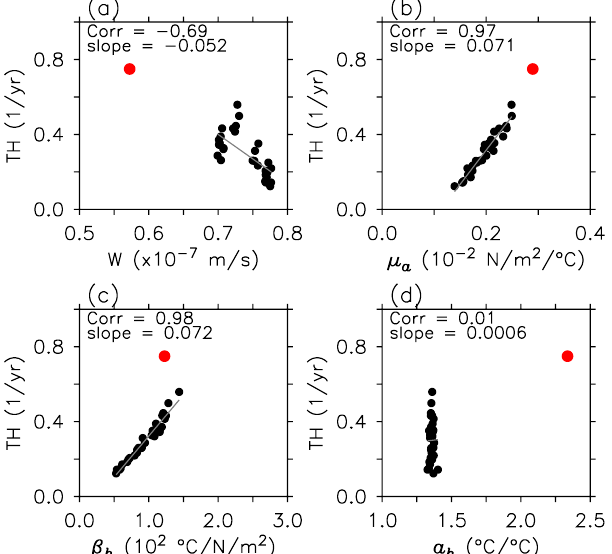
Figure 4. Factor for thermocline feedback error. Scatter plots of thermocline feedback versus its contributing factors, ( a ) W, ( b ) μ a , ( c ) β h , and ( d ) a h from 1- to 6-month lead times. Black dots indicate individual member forecasts. The observed counterparts (red dots) for the thermocline feedback and contributing factors are also shown. Correlation coefficients and regression slopes, computed using samples from individual forecasts, are also